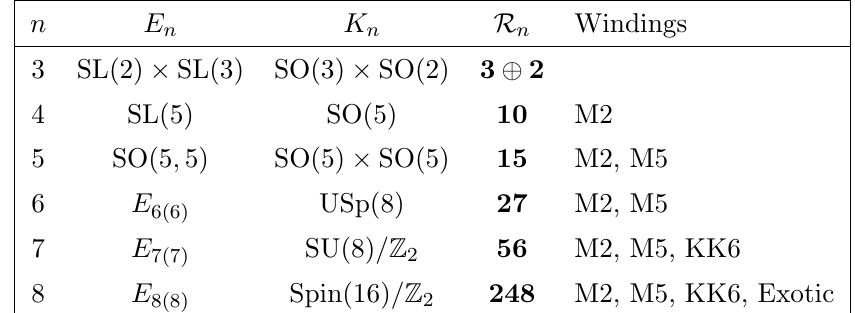
, along with their maximal compact subgroups n ( n )